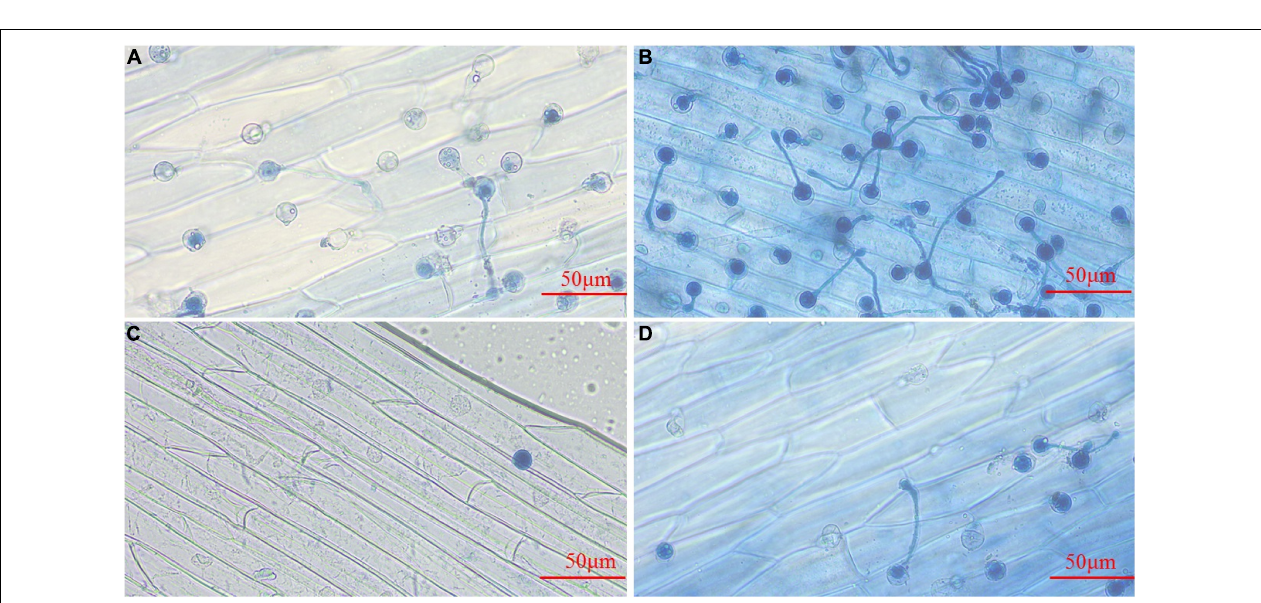
FIGURE 3 | Effect of 4-Ethylphenol on zoosporangium formation and zoospore release. (A) Inhibition rate of 4-Ethylphenol on P. sojae and P. nicotianae zoosporangium formation; (B) inhibition rate of 4-Ethylphenol on P. sojae and P. nicotianae zoospore release. The experiment was repeated three times with similar results.